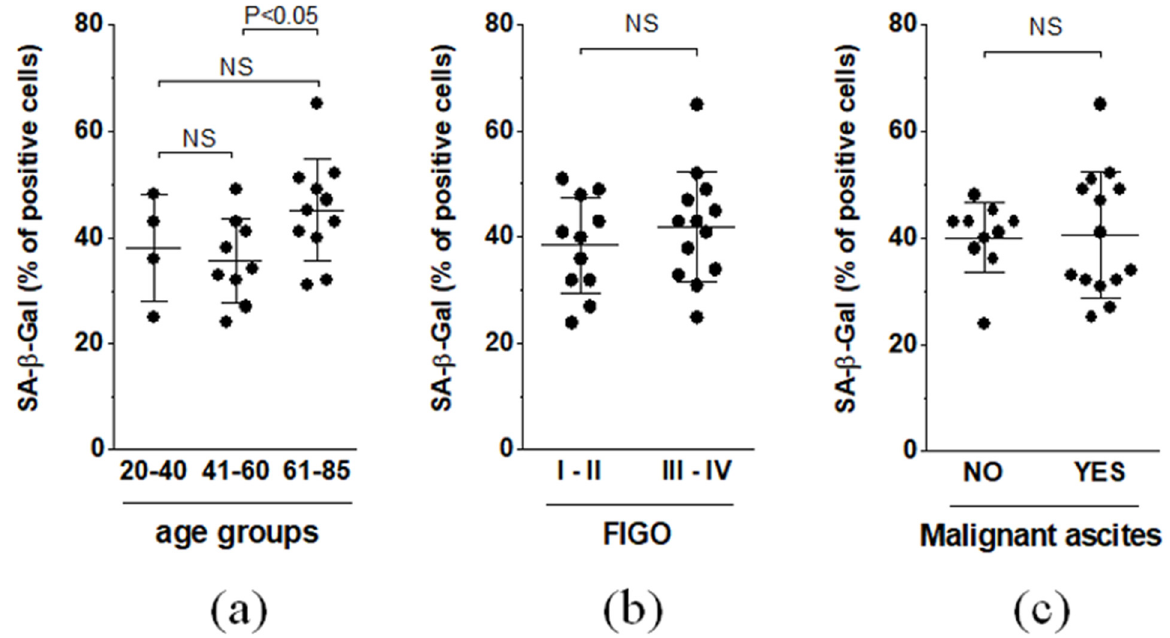
Figure 2. Comparison of the average areas representing the expression of SA- β -Gal with respect to patient age ( a ), FIGO stage ( b ), and malignant ascites status ( c ). Experiments were performed on 24 separate ovarian tumors obtained from different patients. The results are expressed as the means ±